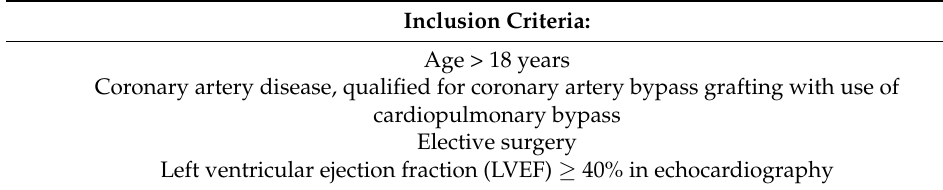
Inclusion Criteria: